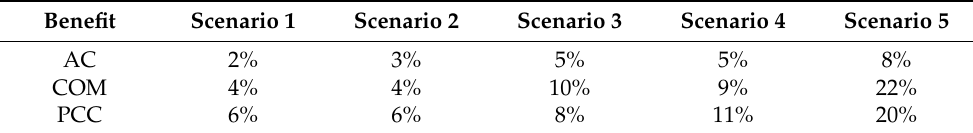
Table 9. Rate of benefit reduction with different amount of error